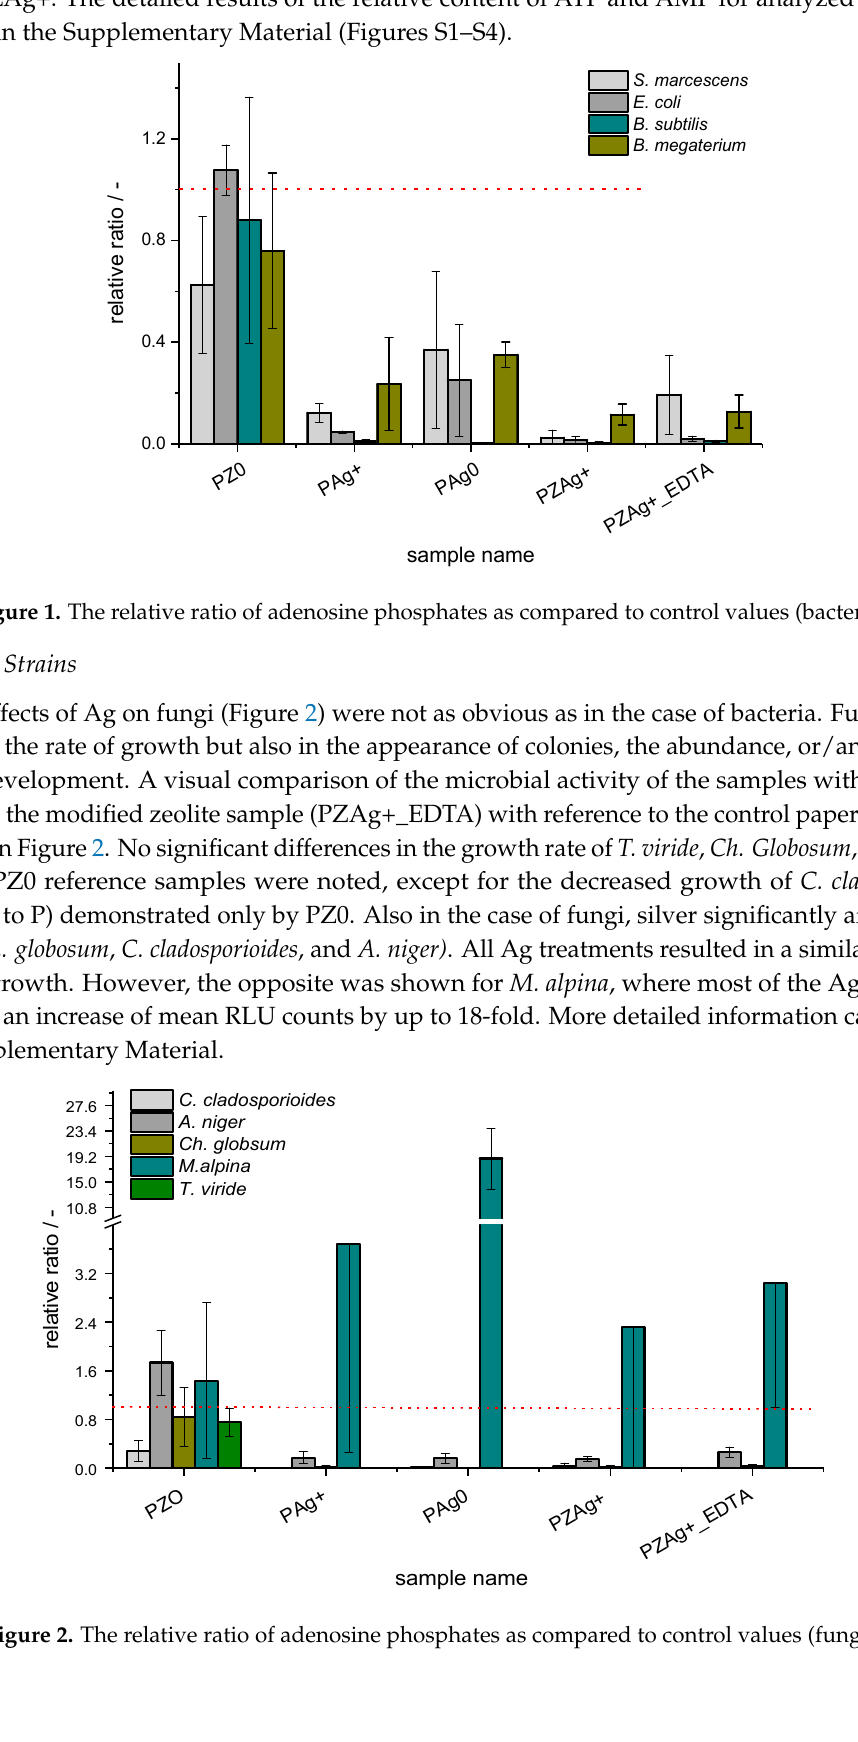
Figure 3. Examples of antifungal activity of silver ‐ exchanged zeolite PZAg+_EDTA ( C , F , I ); reference samples of pure paper P ( A , D , G ); and paper with silver nanoparticles PAg0 ( B , E , H ). As regards the fungi distribution within the samples, the mycelium of A. niger , T. viride , and C. cladosporioides did not penetrate the PZAg + _EDTA sample. For Ch. Globosum , a poor inhibition zone was visible for PZAg + , while in the case of other samples the inhibition zone was quite visible. The mycelium of Mortierella alpina easily colonized paper samples enriched with Ag. The detailed results